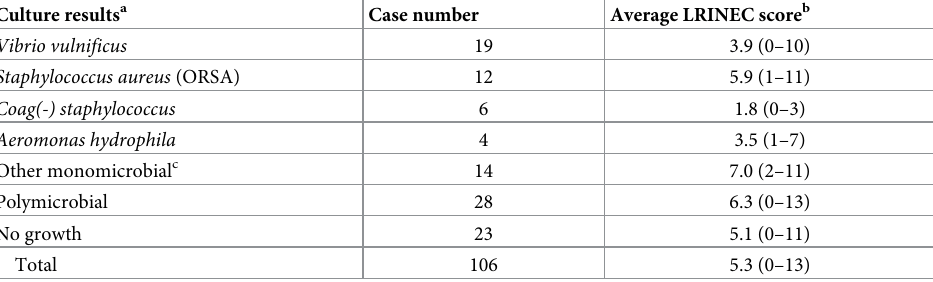
Table 3. The bacterial culture results and average LRINEC score of patients with necrotizing fasciitis.